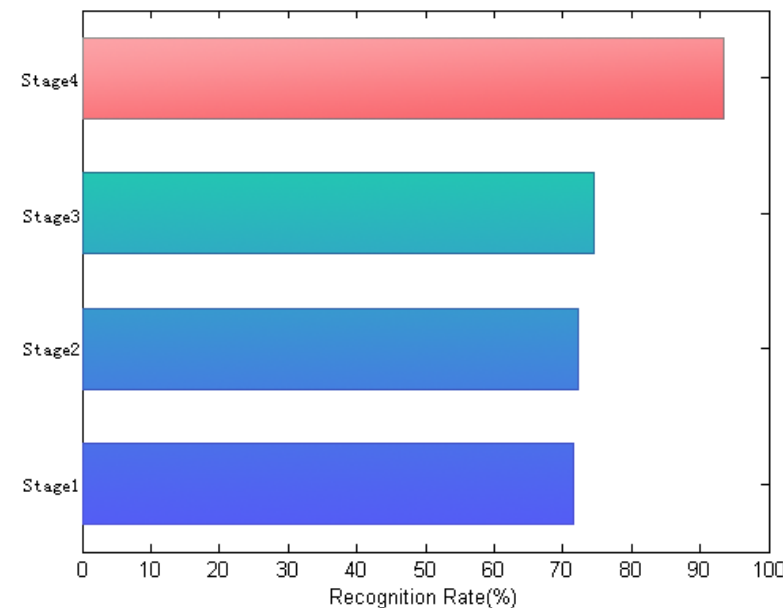
Figure 12. Different learning stages, denoted as Stage1: conventional collaborative representation-based classification (CRC), Stage2: histogram-based CRC, Stage3: histogram-based-elimination CRC and Stage4: histogram-based-elimination CRC using